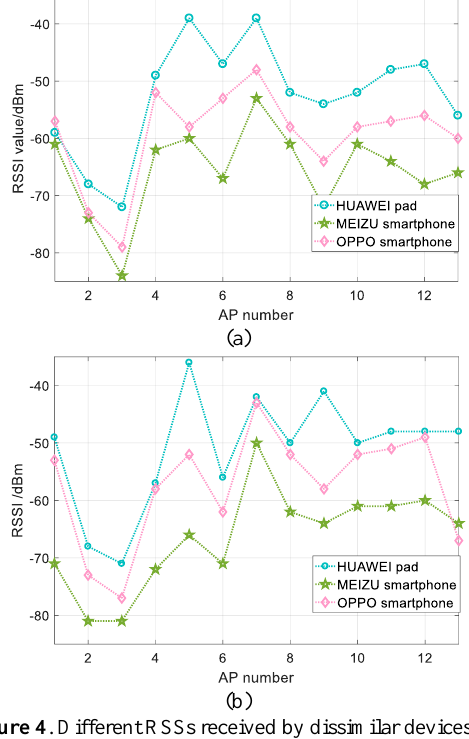
Figure 4 . Different RSSs received by dissimilar devices: (a) Point a, (b) Point b.